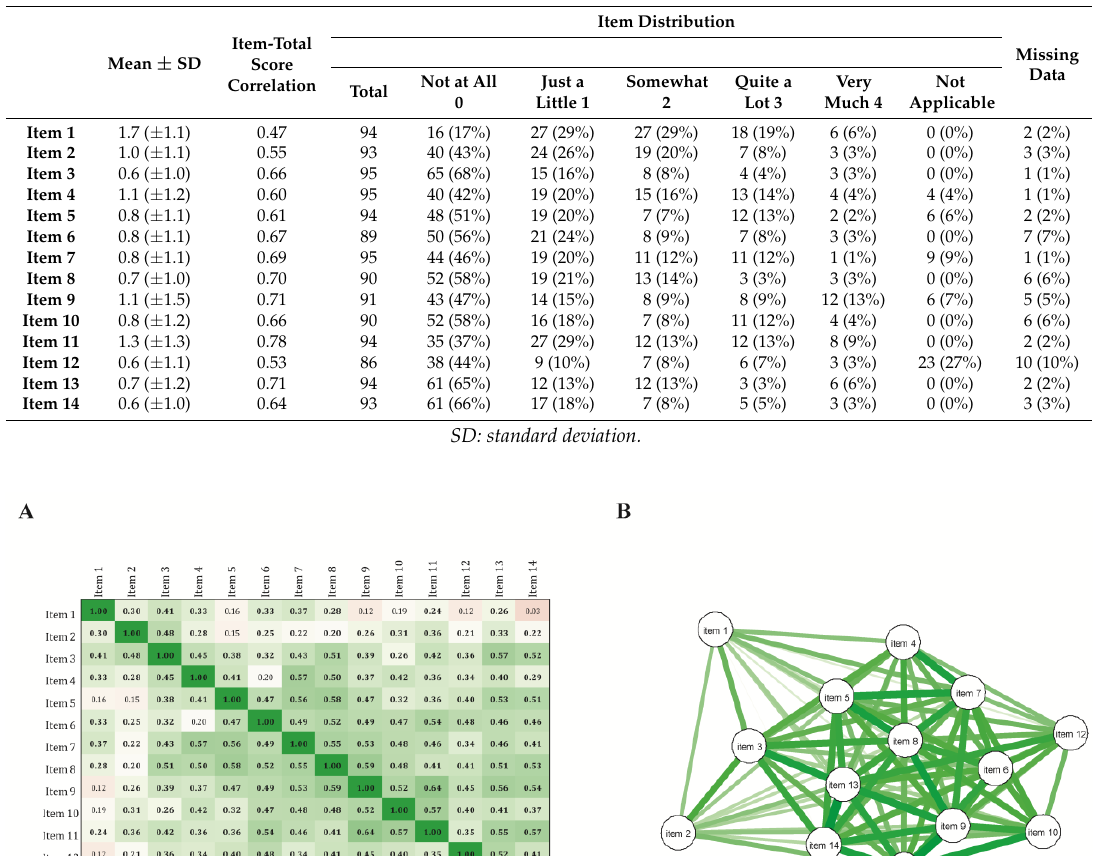
Table 2. Item distribution and item-total score correlations.